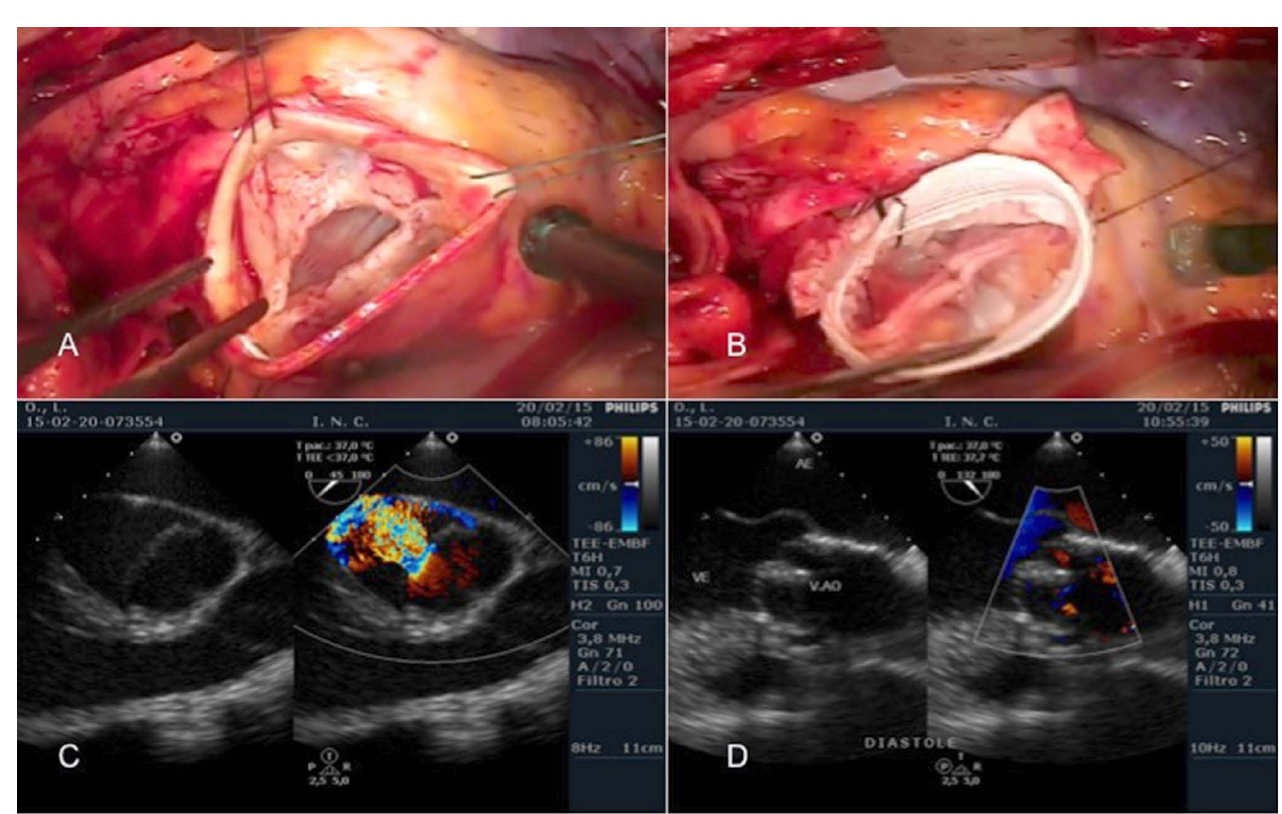
Fig. 2 – A - Bicuspid aortic valve, with thickening of the free edges, prolapse of the fused cusp. There were significant dilation of the ring and the entire aortic root. B - Correction was made by the reimplantation technique (David), and leaflet prolapse correction, requiring plication of both cusps for adequate valve competence. C - Intraoperative echocardiogram before correction, demonstrating valve prolapse and important degree of AI. D - Intraoperative echocardiogram after correction, showing good surface of coaptation of the cusps and a competent valve.